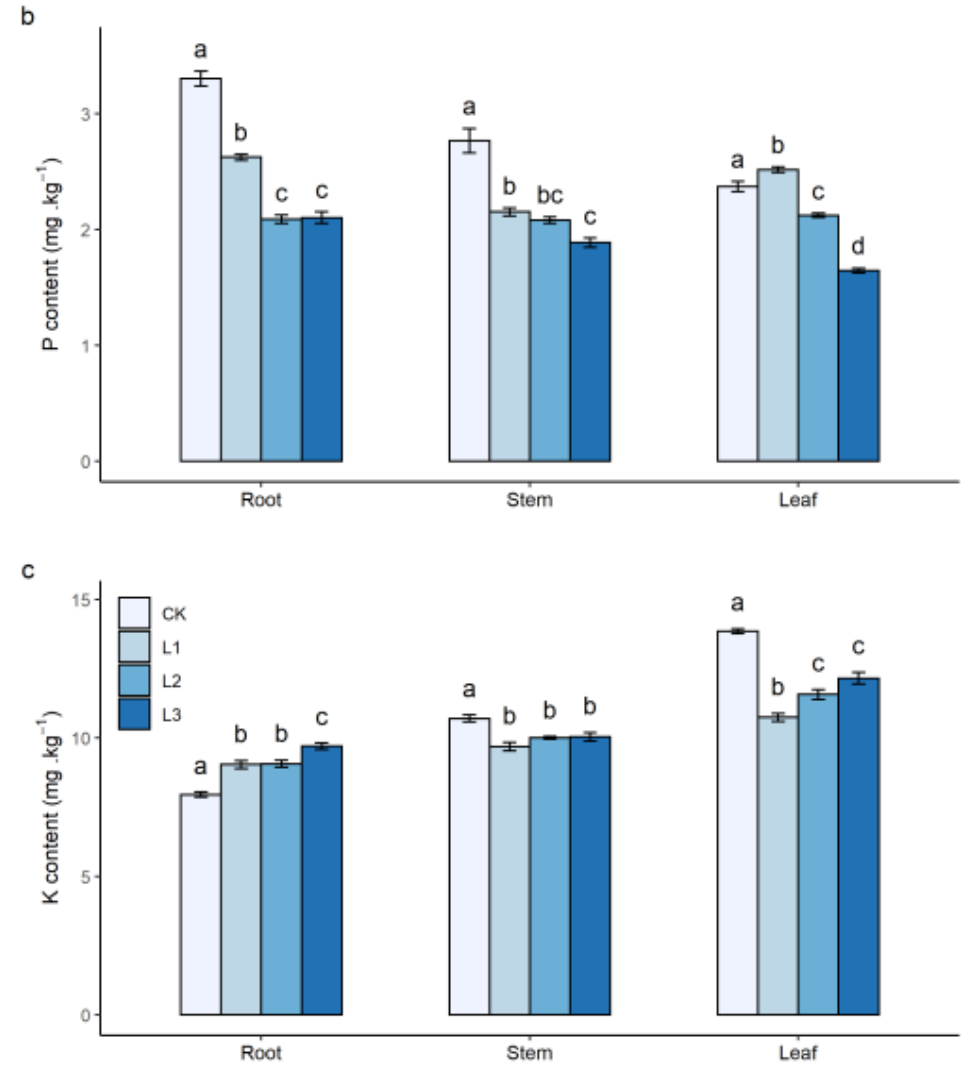
Figure 2. The content of nutrient elements in three organs (roots, stems, and leaves) of plants in response to different N addition treatments. N content ( a ), P content ( b ), and K content ( c ). Bars represent mean value with standard error ( ± SE). Different colors indicate the different treatments. Different letters indicate the significance among different levels of N application ( p <